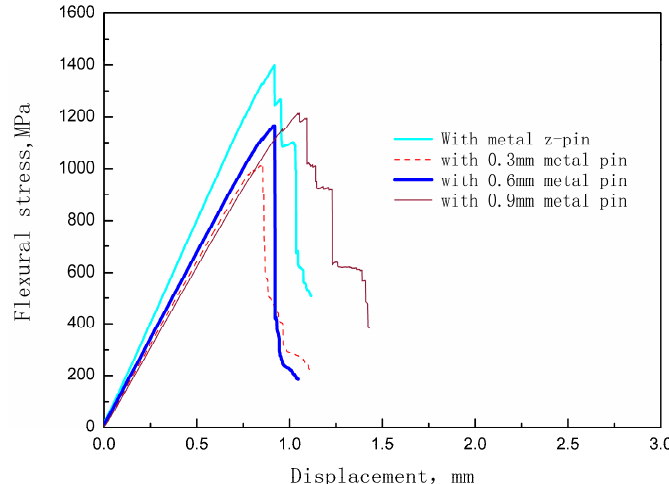
Figure 7. Typical Cf/Al stress-deflection results for samples without a z-pin and those with a z-pin content of 1% and different diameters.